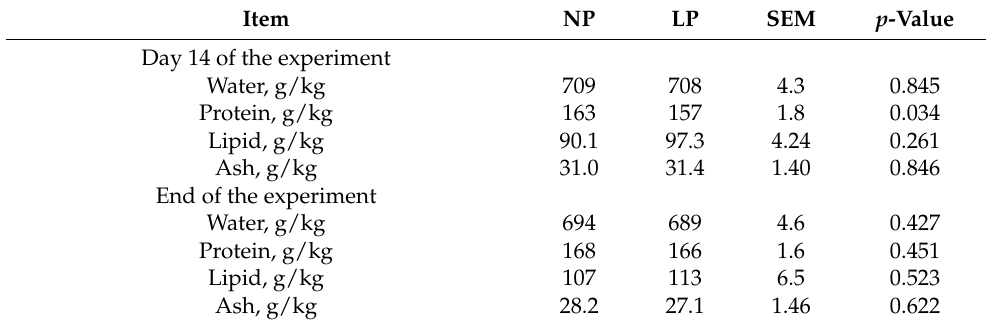
Table 3. Effects of protein restriction and realimentation on the chemical body composition of piglets 1